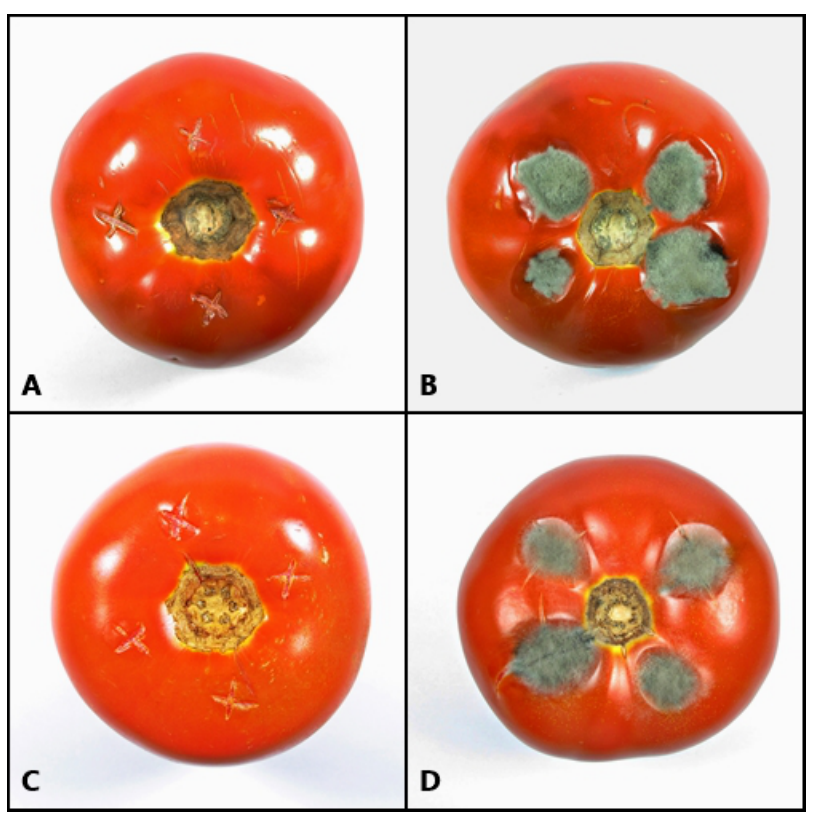
Figure 6. Effect of P aib on growth of A. alternata in tomatoes 8 days after spore inoculation and application of treatment. ( A ) extract with P aib ; ( B ) control; ( C ) clotrimazole and ( D ) sterile distilled water.